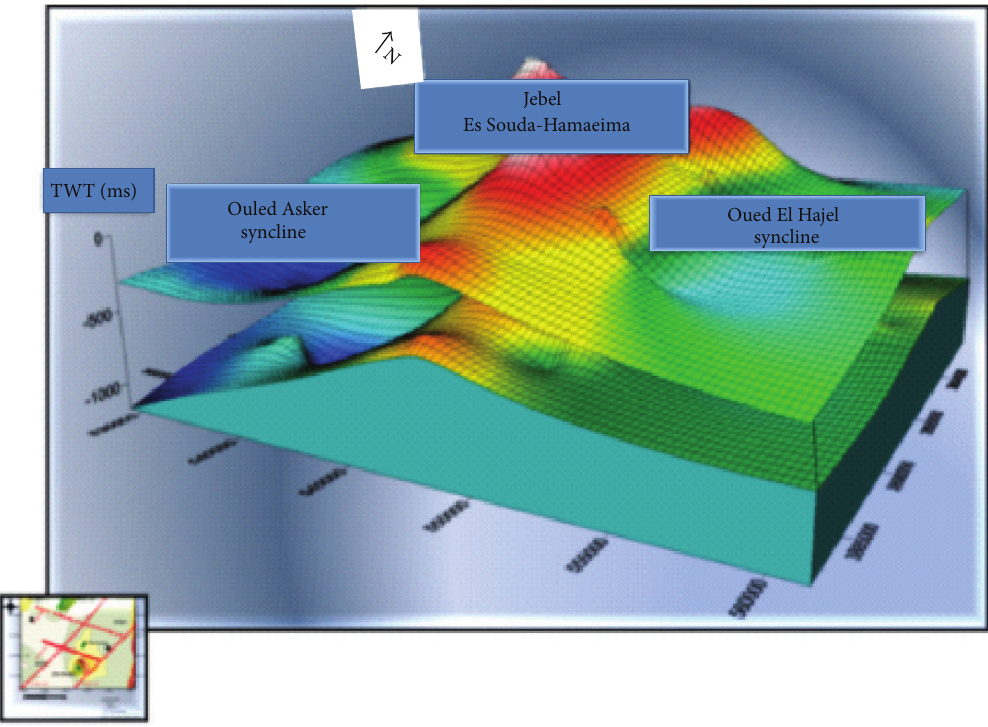
Figure 16: 3D visualization of the Oligocene-Aquitanian (Lower Miocene)